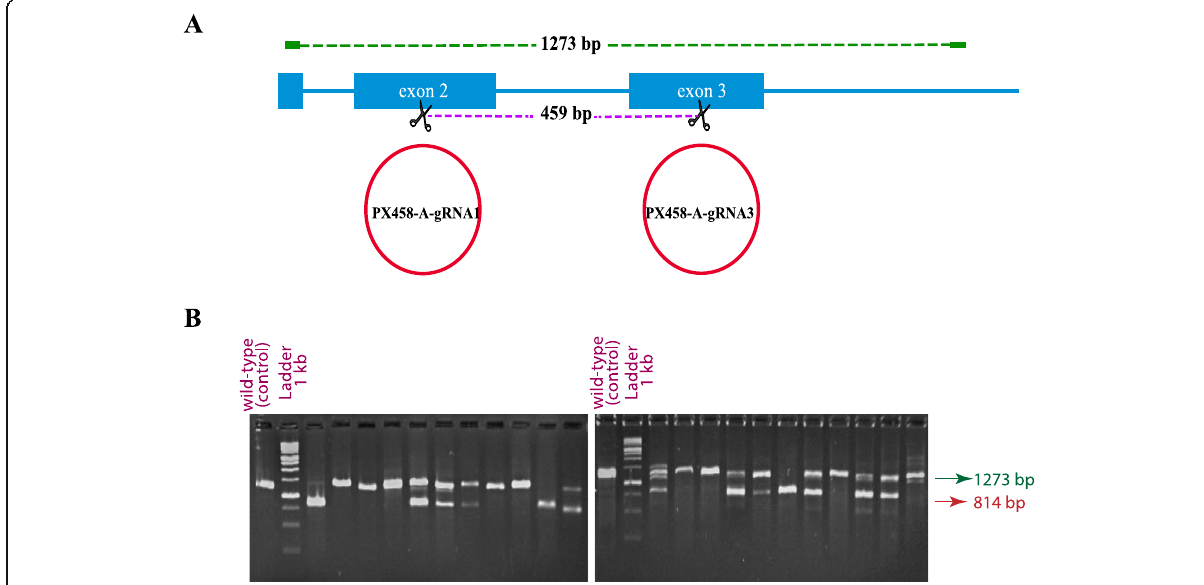
Fig. 4 a Schematic illustration of cleavage positions between exons 2 and 3 (459 bp) and primers locations for detecting desired deletion in HLA- A gene. b Agarose gel electrophoresis of DNA extracted from single-cell colonies are showing colonies with deleted allele (814 bp) and wild-type allele (1273 bp)